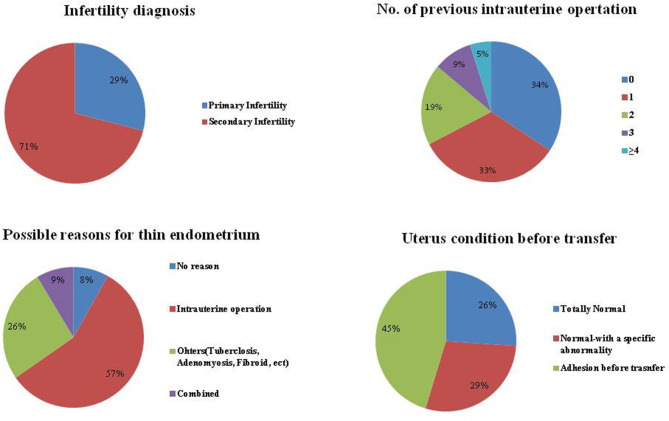
Detailed information for patients included.